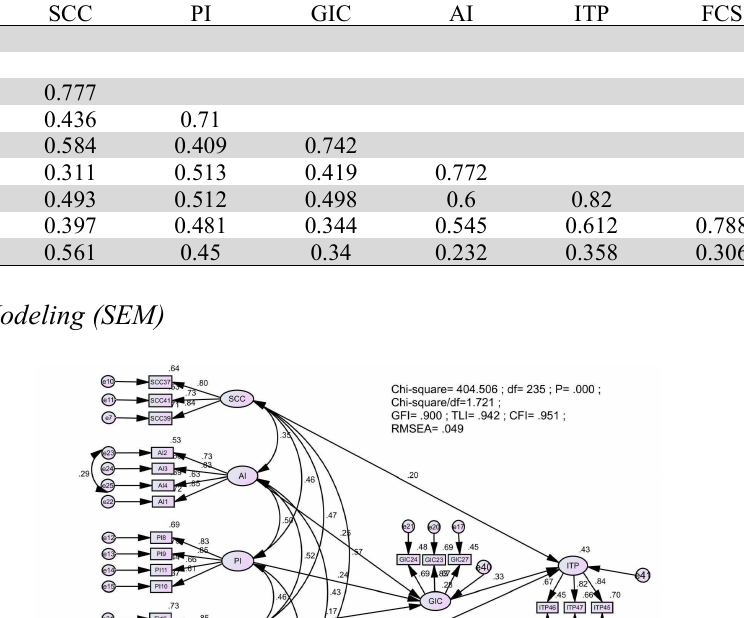
Construct Correlation matrix (square root of the AVE on the diagonal) (GIC28, GIC29 deleted) FI COE SCC PI GIC AI ITP FCS FCC